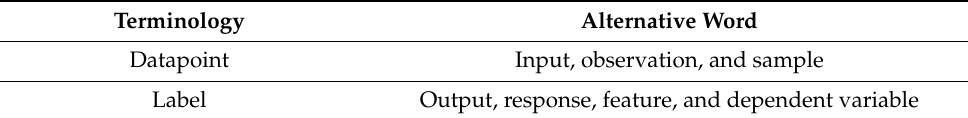
Figure 2. Traditional centralised learning: ML runs in the cloud, gathering data from different Table 1. Terminology used in the hospitals.